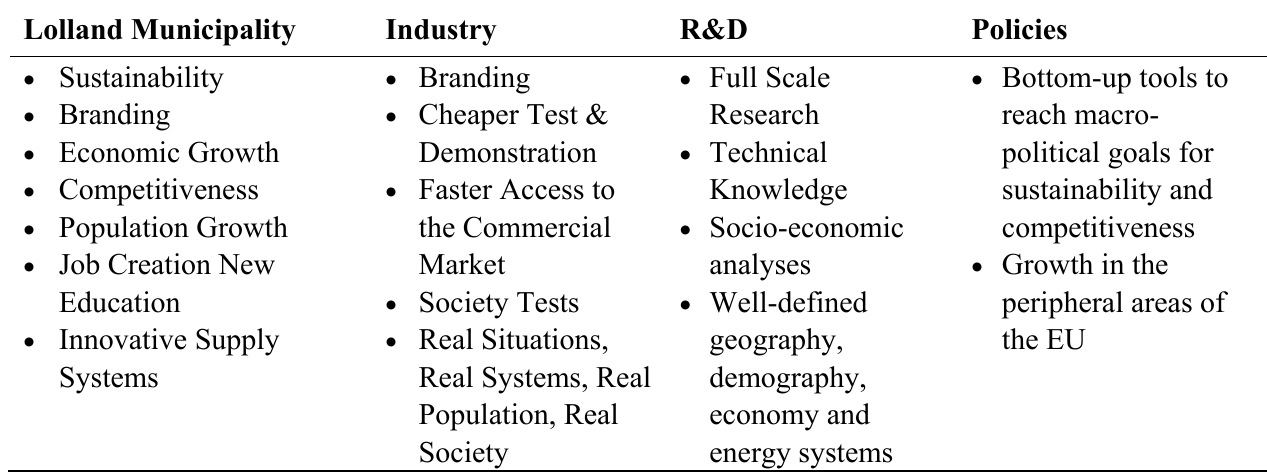
Table 1. Lolland CTF